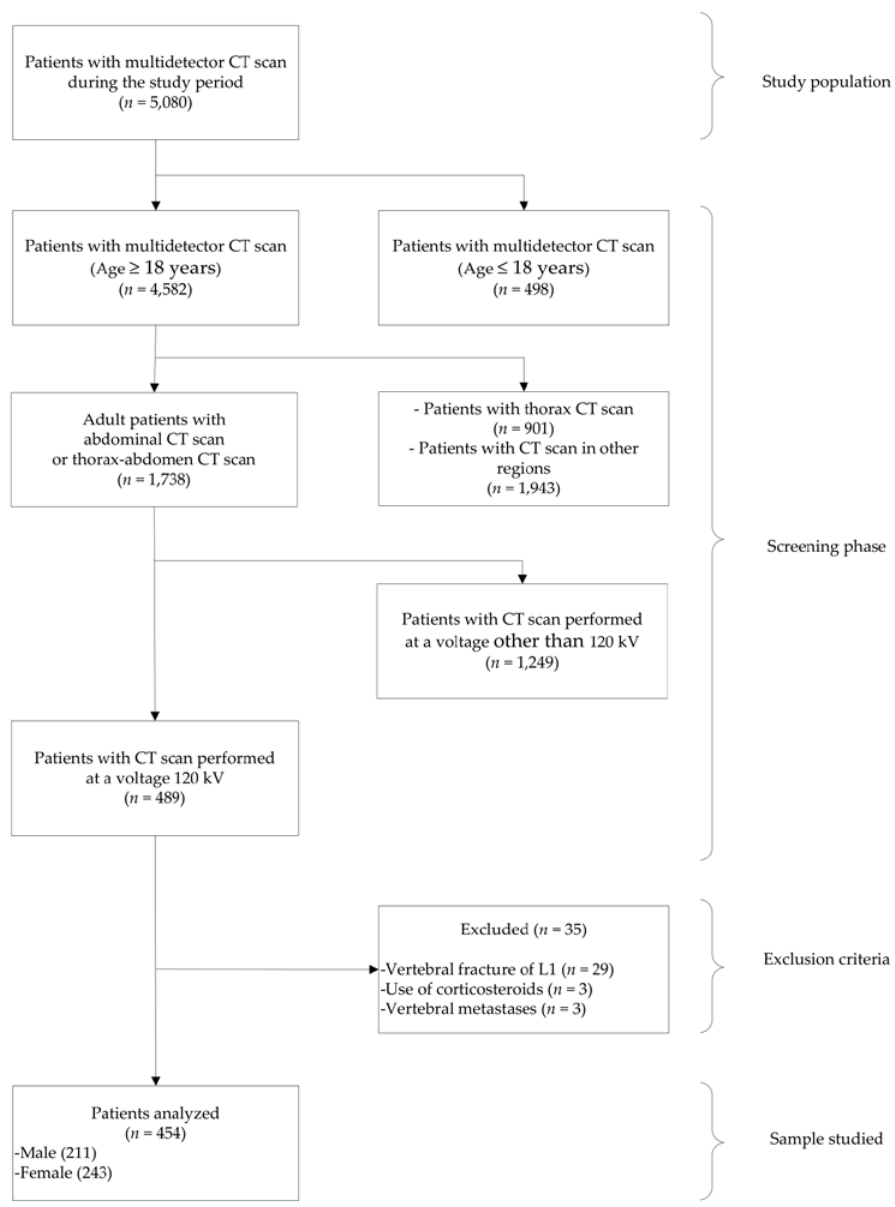
Figure 2. Flowchart of patient